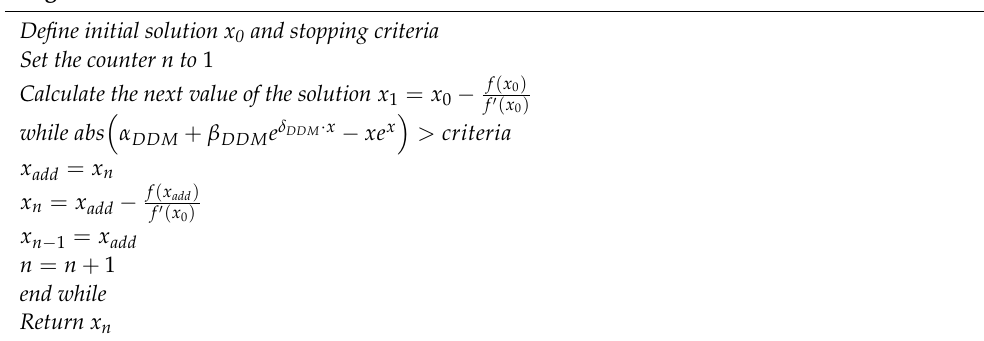
Algorithm 2: Procedure of modified Newton’s iterative